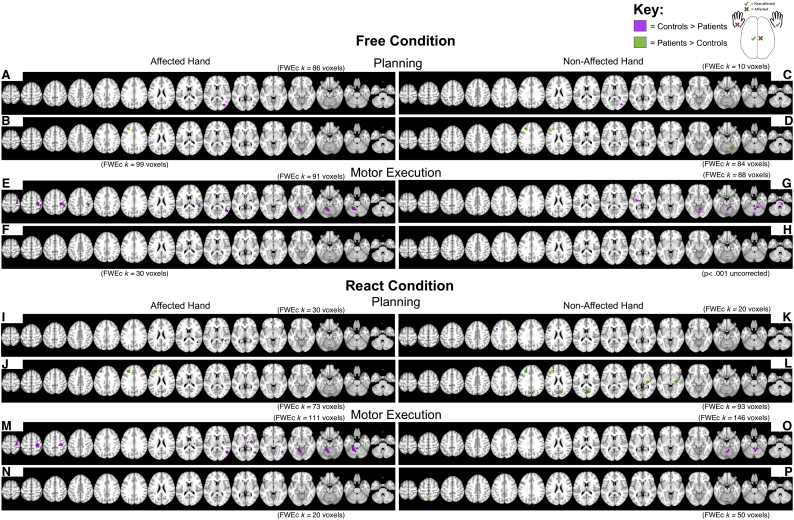
Between-group analysis.The outcome of the between-group comparisons for the preparation (PLAN) and the execution (MOTOR) of the movement sequence. Represented are the between-group activation comparisons during the planning during the self-initiated (FREE; A–D) and externally cued (REACT; I-L) action, along with the MOTOR between-group activation comparisons for the self-initiated (FREE; E-H) and externally cued (REACT; M-P) action. The activations are color coded for the comparison direction, Controls > Parkinson's disease Patients (in violet; A, C, E, G, I, K, M, O) and Parkinson's disease Patients > Controls (in green; B, D, F, H, J, L, N, P). Analyses shown are the significant between-group comparisons (the reported statistical threshold are either p < .001 uncorrected at the voxel-level or p < .001 uncorrected at the voxel-level with a cluster size correction (k, indicated; p < .05 corrected at the cluster-level: FWEc) represented on an MNI-T1-template brain, displayed using multiple axial transections. Coordinates shown (z only) are in MNI-space.